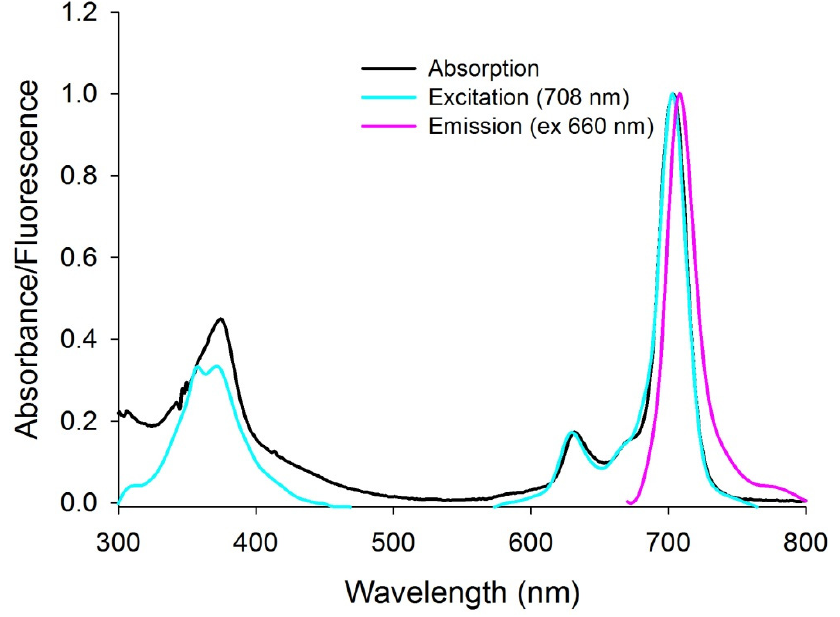
Figure 4. Absorption, excitation and emission spectra of 7 in DMF.